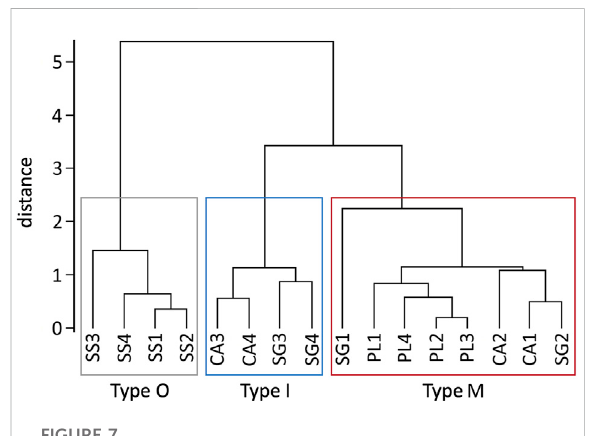
FIGURE 7 Dendrogram obtained from a cluster analysis performed on mean SOD 20 rate, TN concentration, and D50 data (complete- linkage hierarchical clustering).